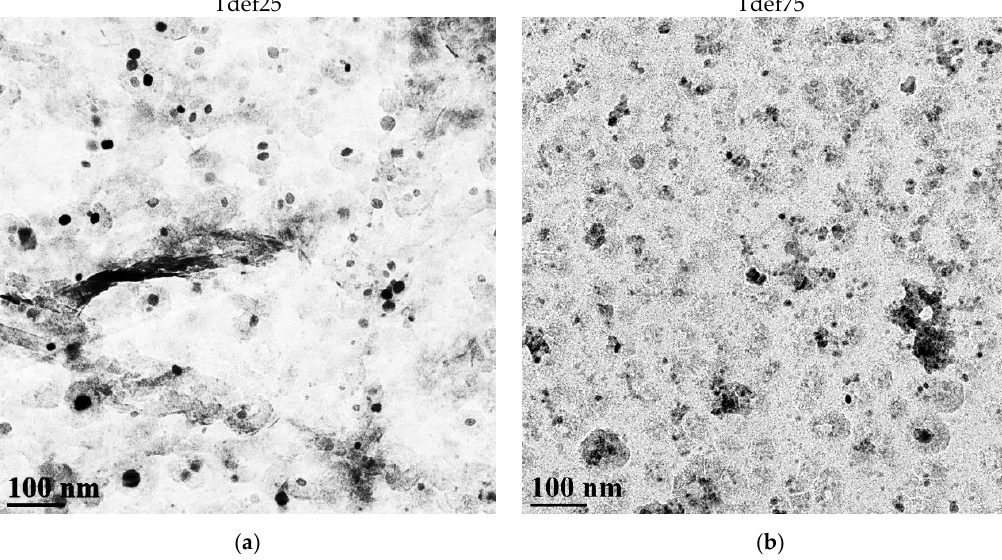
Figure 13. TEM images obtained in NbV recrystallized austenite and different ferrite contents prior to intercritical deformation: ( a ) Tdef25 and ( b ) Tdef75.